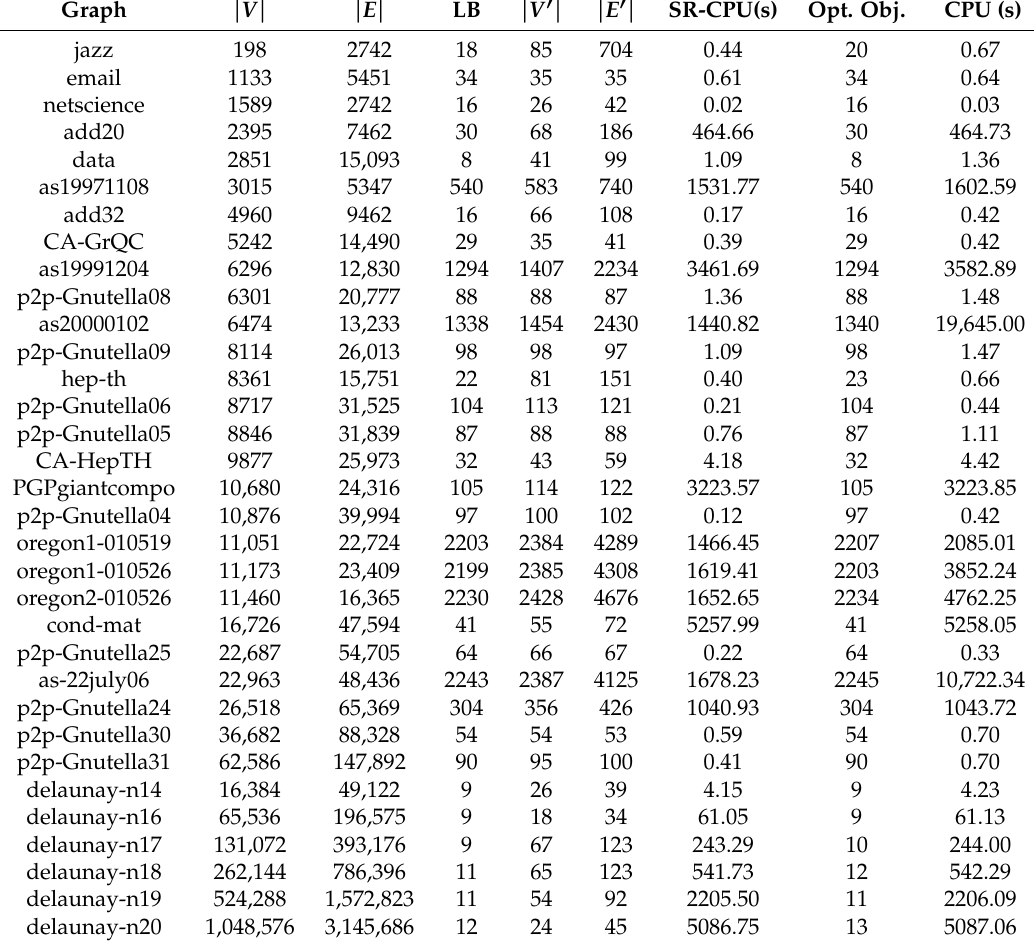
Table 1. Computational results for the MB problem on instances from DIMACS Clustering challenge and Stanford Large Network Dataset Collection (SNAP)